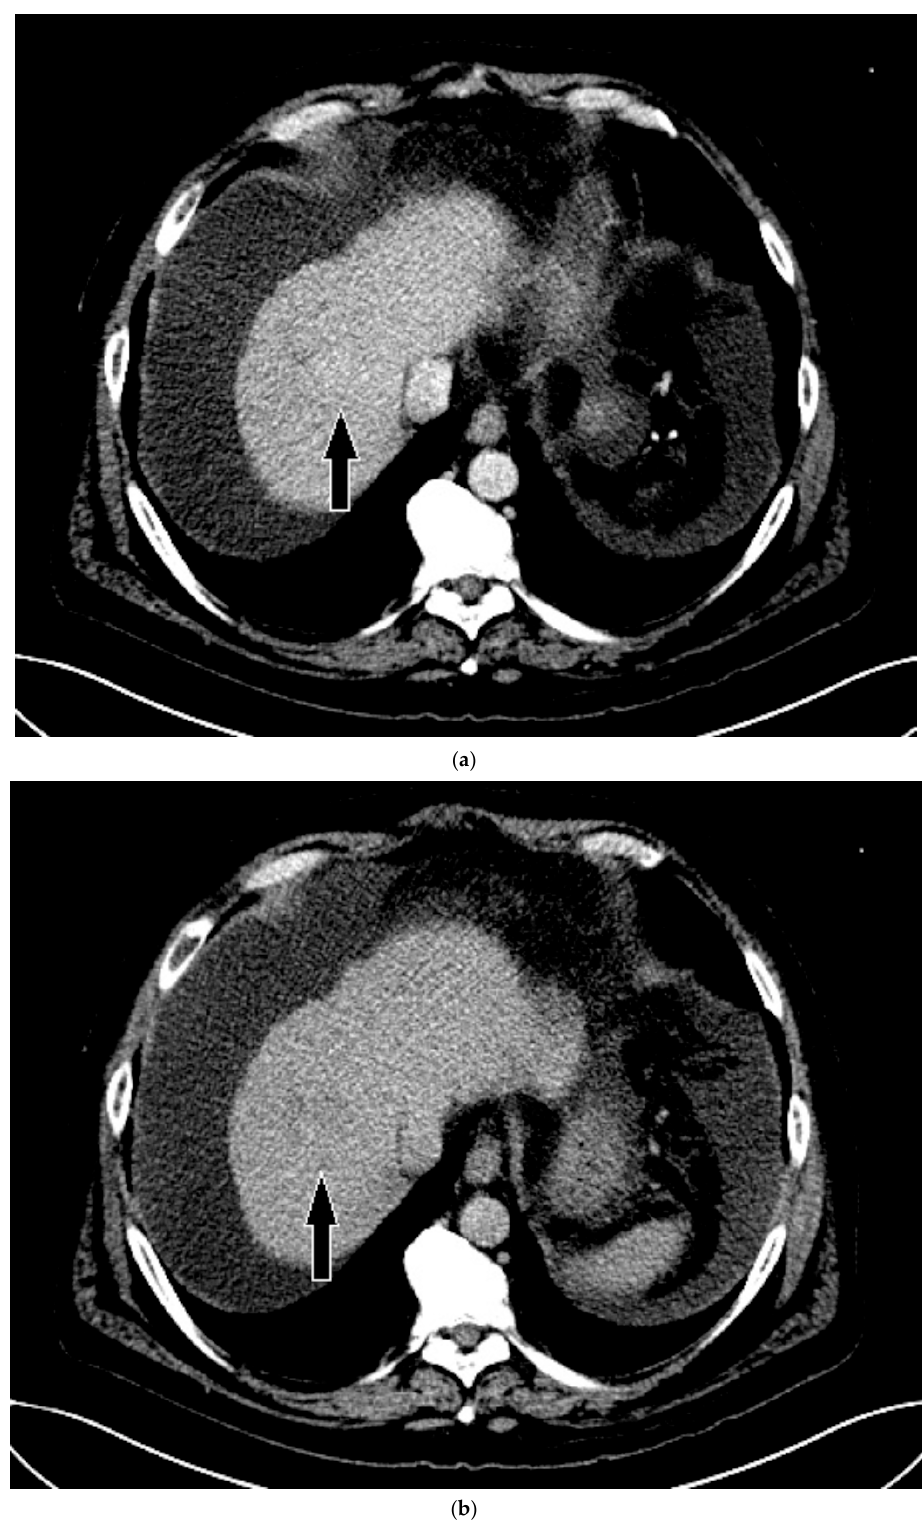
Figure 6. Patient 3 CT images using liver windows to highlight the subtle enhancement and washout of the lesion seen on CEUS (white arrow): ( a ) late arterial phase axial contrast-enhanced CT; ( b ) 3 min delayed